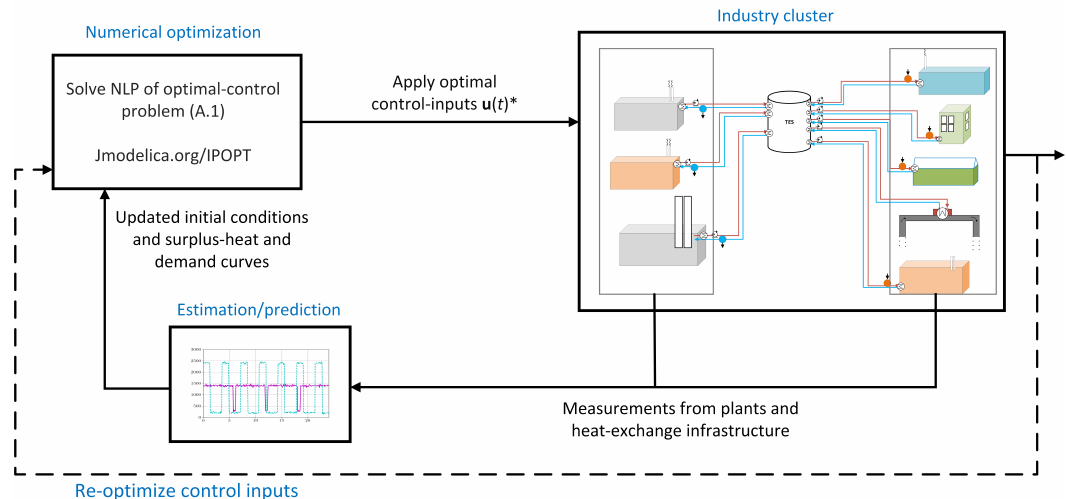
Figure 2. Illustration of the proposed optimal-control scheme.